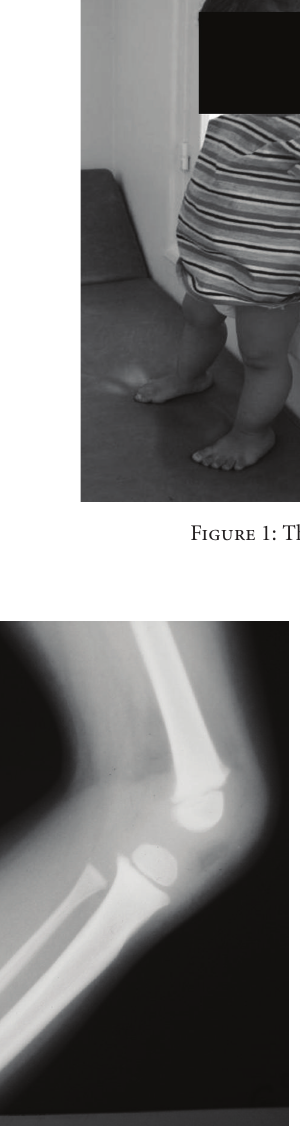
Figure 2: Knee lateral radiographs revealed absence of the patella.